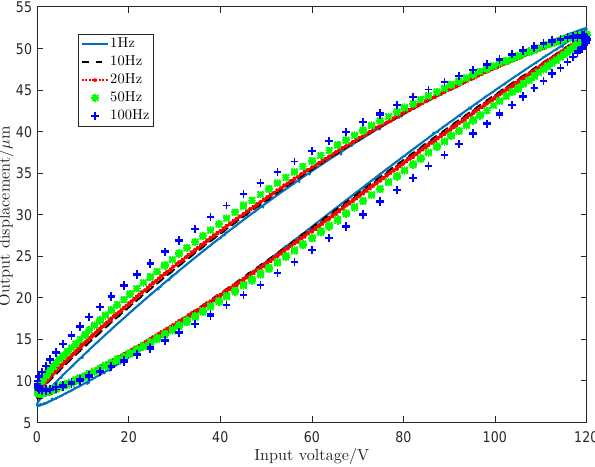
Figure 1. Hysteresis loops under different input